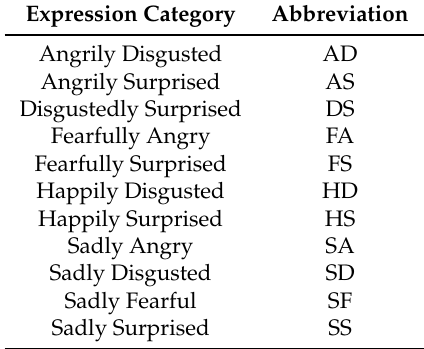
Table 9. The abbreviations of the above expression